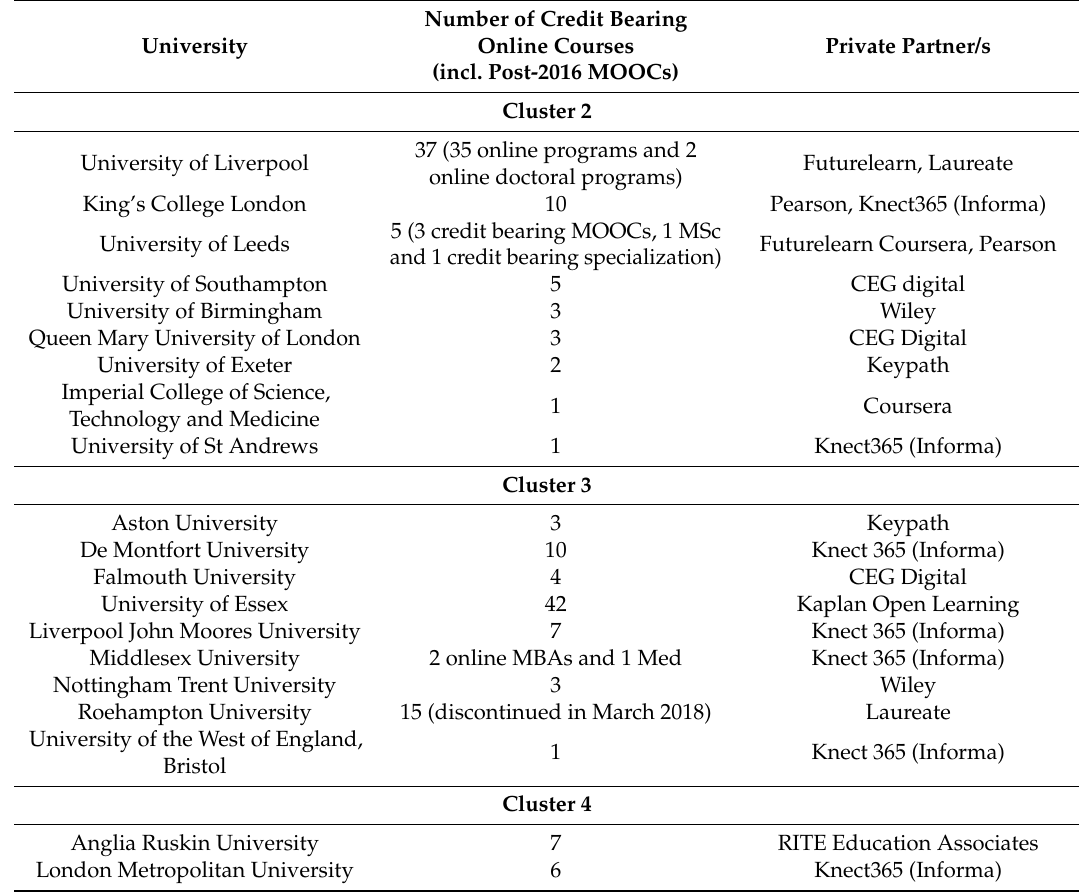
Table 2. The ‘second phase’ of digital higher participation in the UK (online degrees and credit bearing MOOCs).